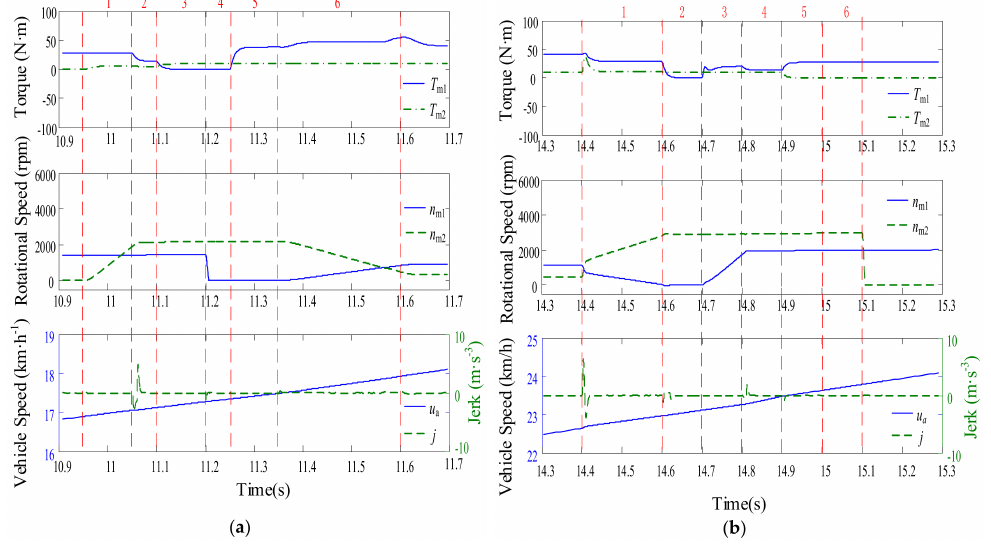
Simulation results of the switching process between M1 and M4: ( a ) M1-to-M4; and, ( b )